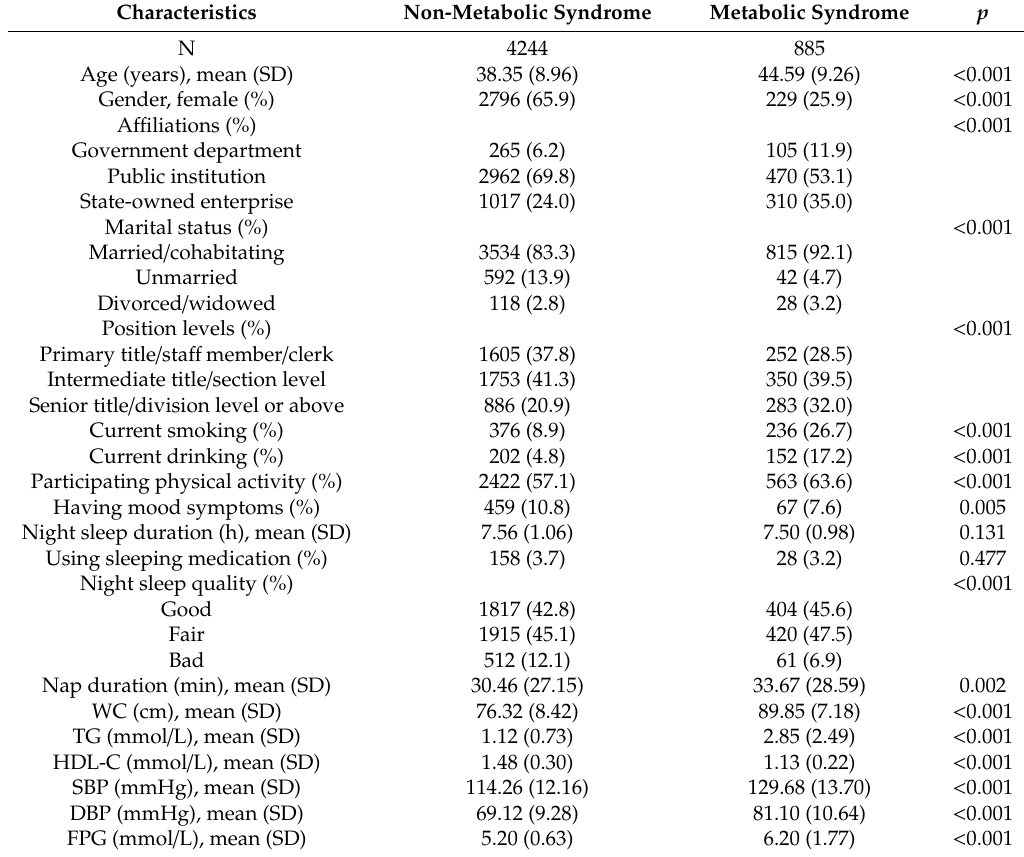
Table 1. Characteristics of participants according to metabolic